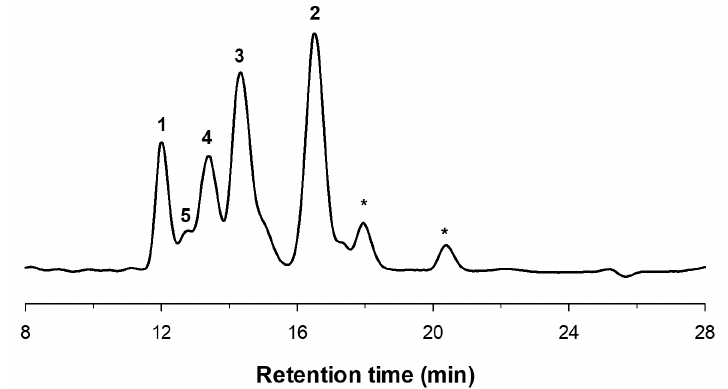
Figure 2. High-performance anion exchange chromatography with pulsed amperometric detection (HPAEC-PAD) chromatogram of the chitooligosaccharides produced by Neutrase 0.8L using chitosan CHIT600. Reaction conditions: 1% (w/v) chitosan, 10% (v/v) Neutrase 0.8L, 50 °C, 50 mM ammonium acetate buffer pH 5.0, 24 h. Identified peaks: (1) GlcN; (2) (GlcN) 2 ; (3) (GlcN) 3 ; (4) (GlcN) 4 ; (5) (GlcN) 5 .